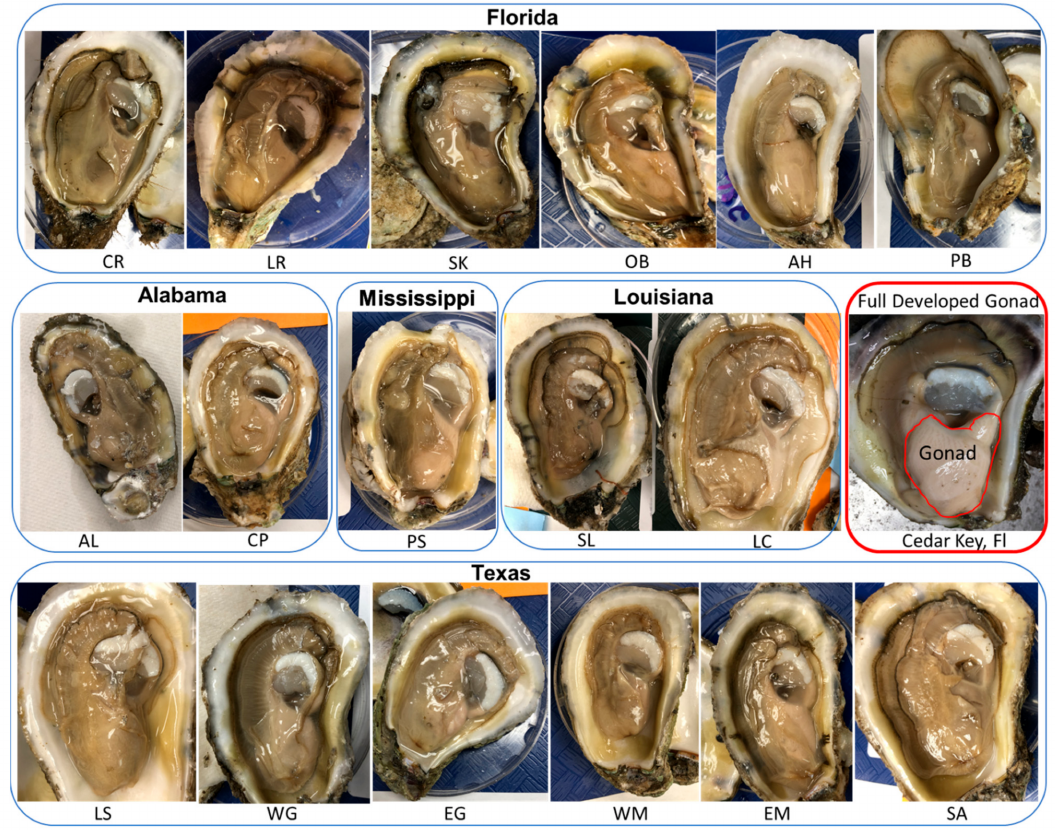
Figure 4. Photographs of gonad development condition of male Eastern oysters Crassostrea virginica included in the sperm repository. One male is presented out of the six males from each of the 17 collection sites along the Gulf of Mexico coast. One example of a fully developed gonad condition of an Eastern oyster (collected from Cedar Key in Florida in April 2021) is present here as a